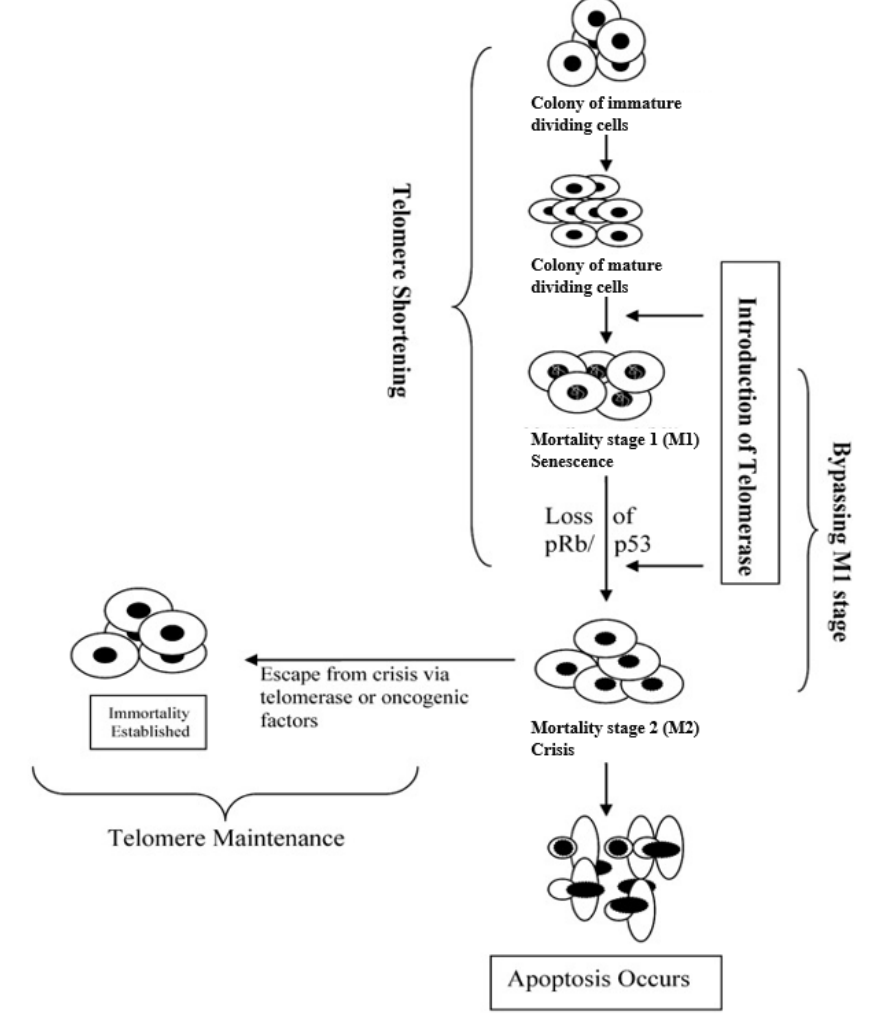
Figure 2. Immortalization can be induced by the expression of telomerase or factors inactivating or bypassing p53/p16/Rb. Reproduced with permission from Maqsood et al., Cell Biology International; published by Wiley Online Library, 2013.